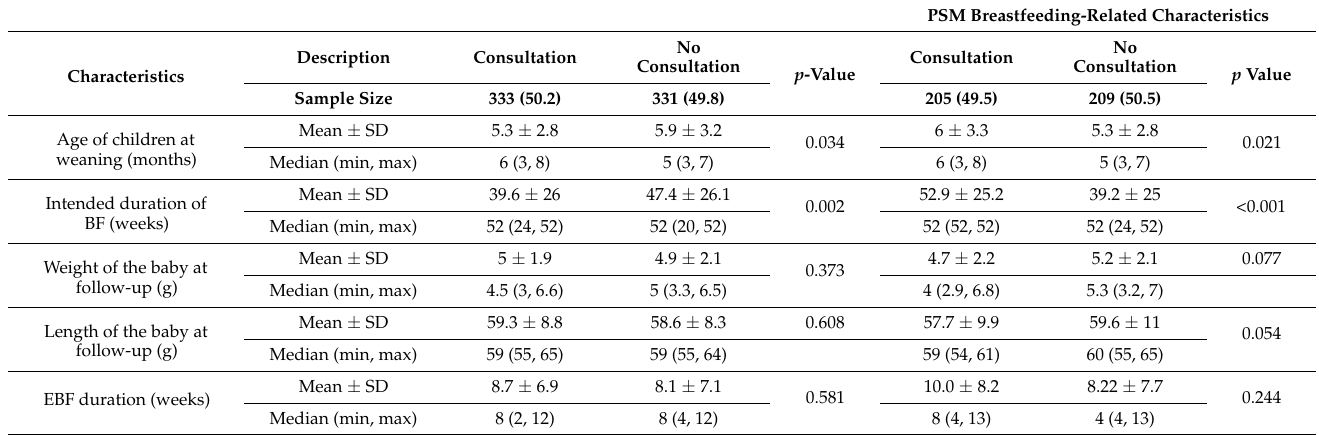
Table 2. Breastfeeding-related characteristics between the two